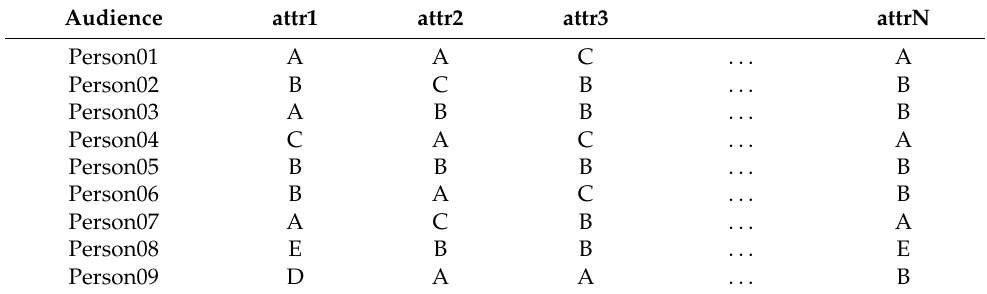
Table 11. All referenceable attributes of the